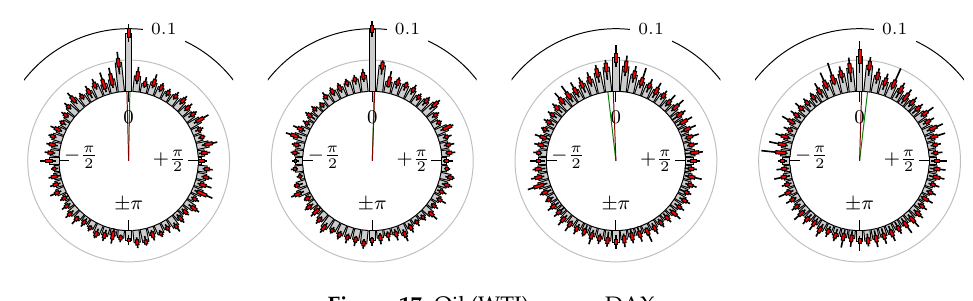
Figure 17. Oil (WTI) versus DAX.